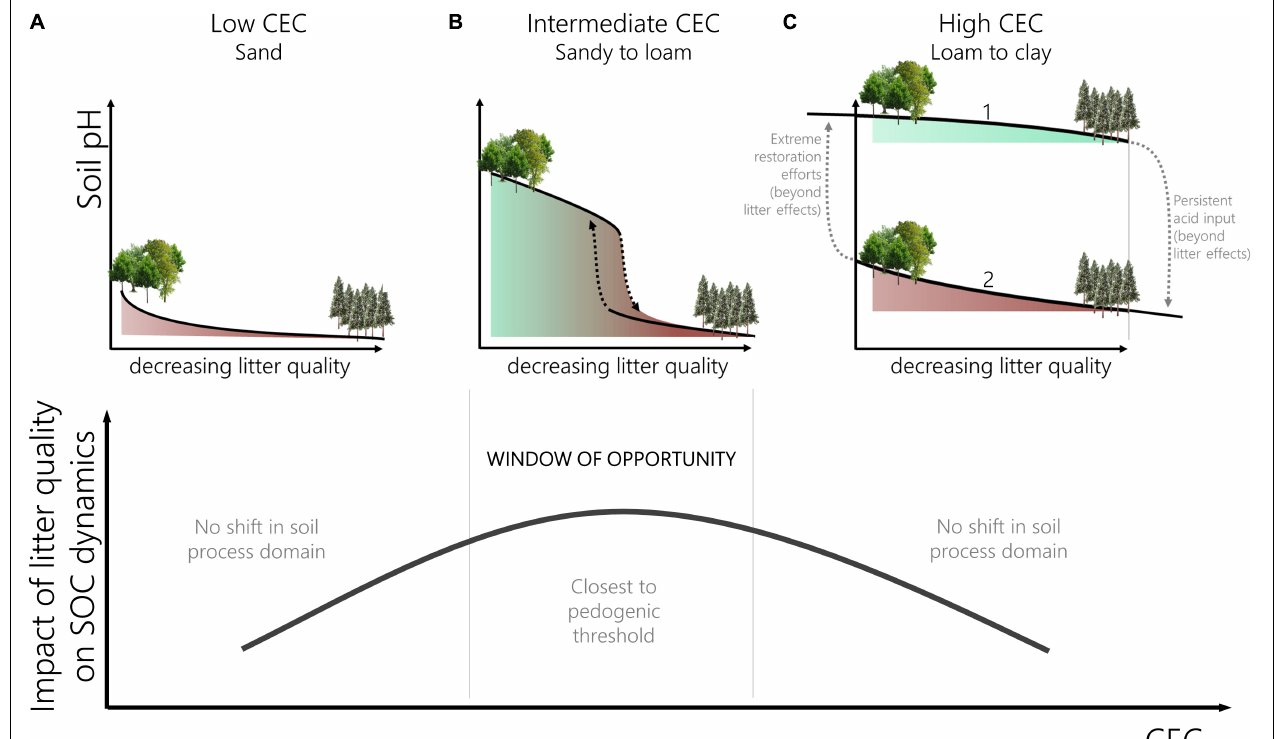
FIGURE 2 | Top: the response curve of soil pH to a change in litter quality (e.g., the input of acidity) differs depending on the context [here cation exchange capacity (CEC)]. The response can be reverse-exponential (A) , show threshold behavior (B) or indicate two alternative stable states (C) . A distinction can be made for the latter: soils with high CEC and high base saturation (BS) (C1) remain in the base exchange domain upon a decrease in litter quality whereas soils with high CEC and low BS (C2) remain in the aluminum domain even with rich litter input. Note that the CEC is assumed constant over the entire profile whereas in practice variability in CEC with depth can occur, which would lead to increased complexity. Bottom: the closer to a pedogenic threshold the higher the impact of tree species litter quality on SOC dynamics indicating a window of opportunity where management efforts to optimize carbon sequestration are most efficient.